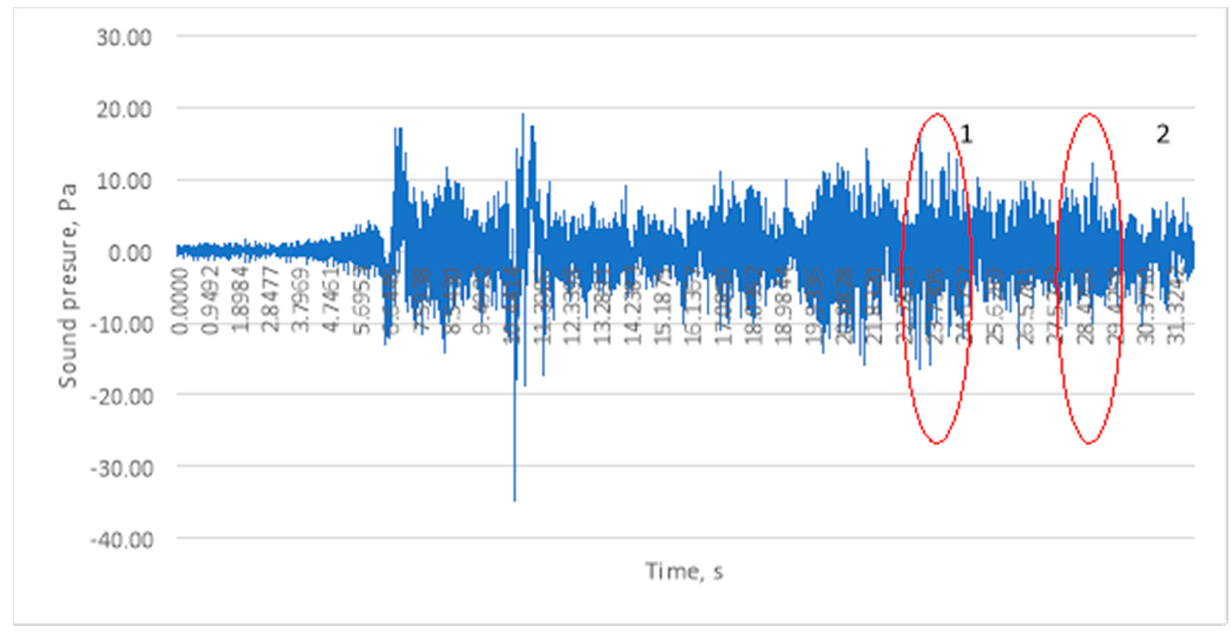
Figure 6. Changes in sound pressure over time.